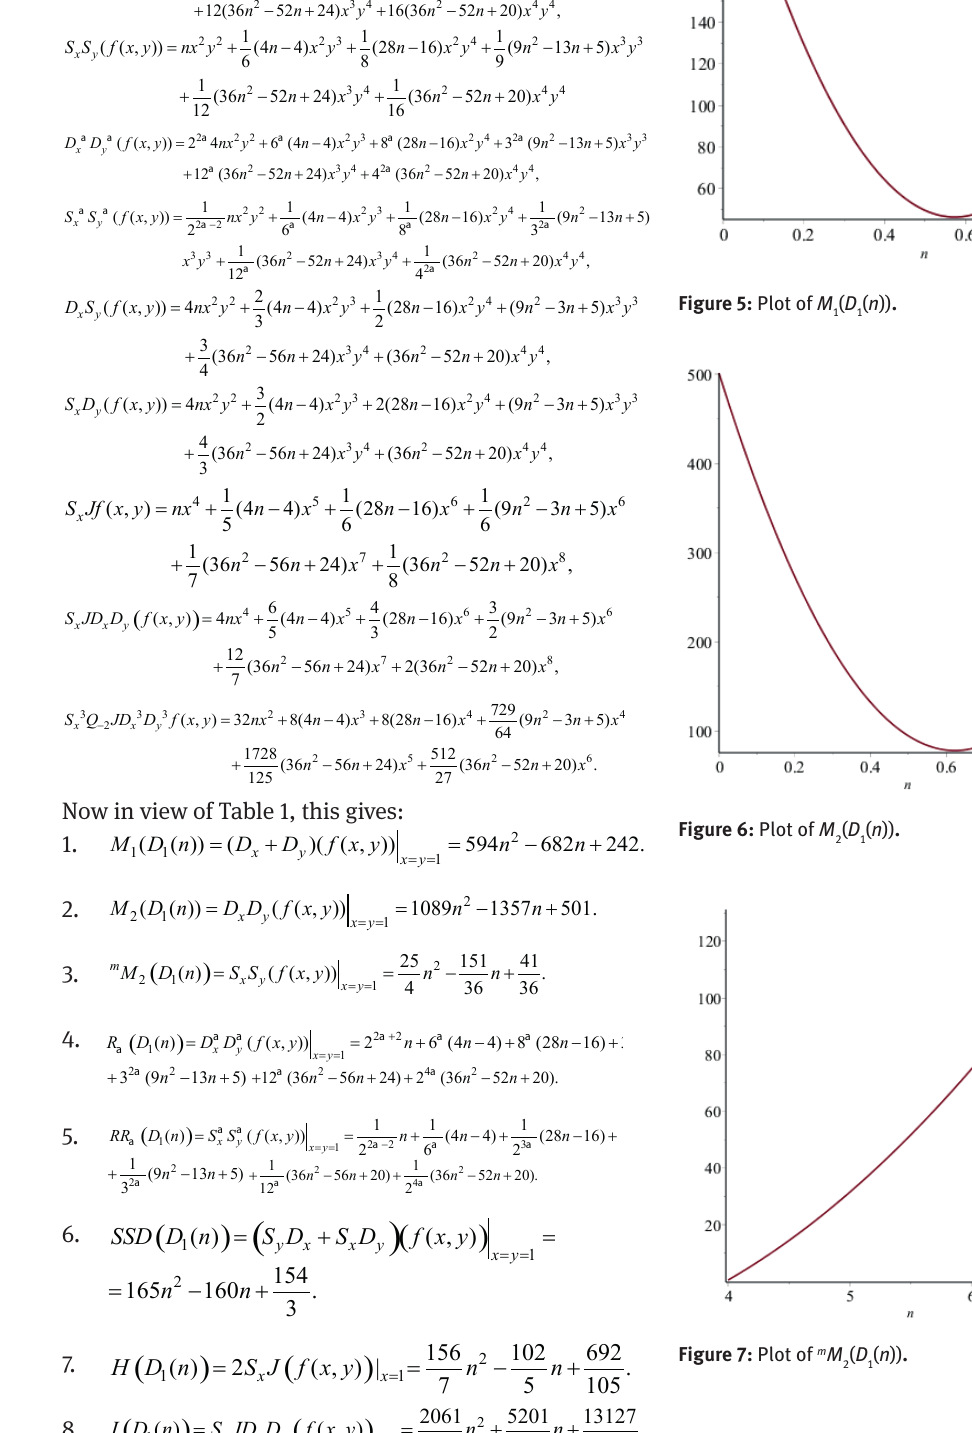
Figure 5: Plot of M